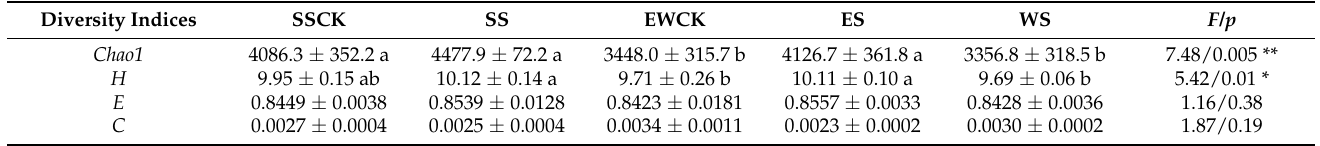
Table 2. Community diversity indices of soil microbes in a tea plantation that was ecologically shaded by roadside